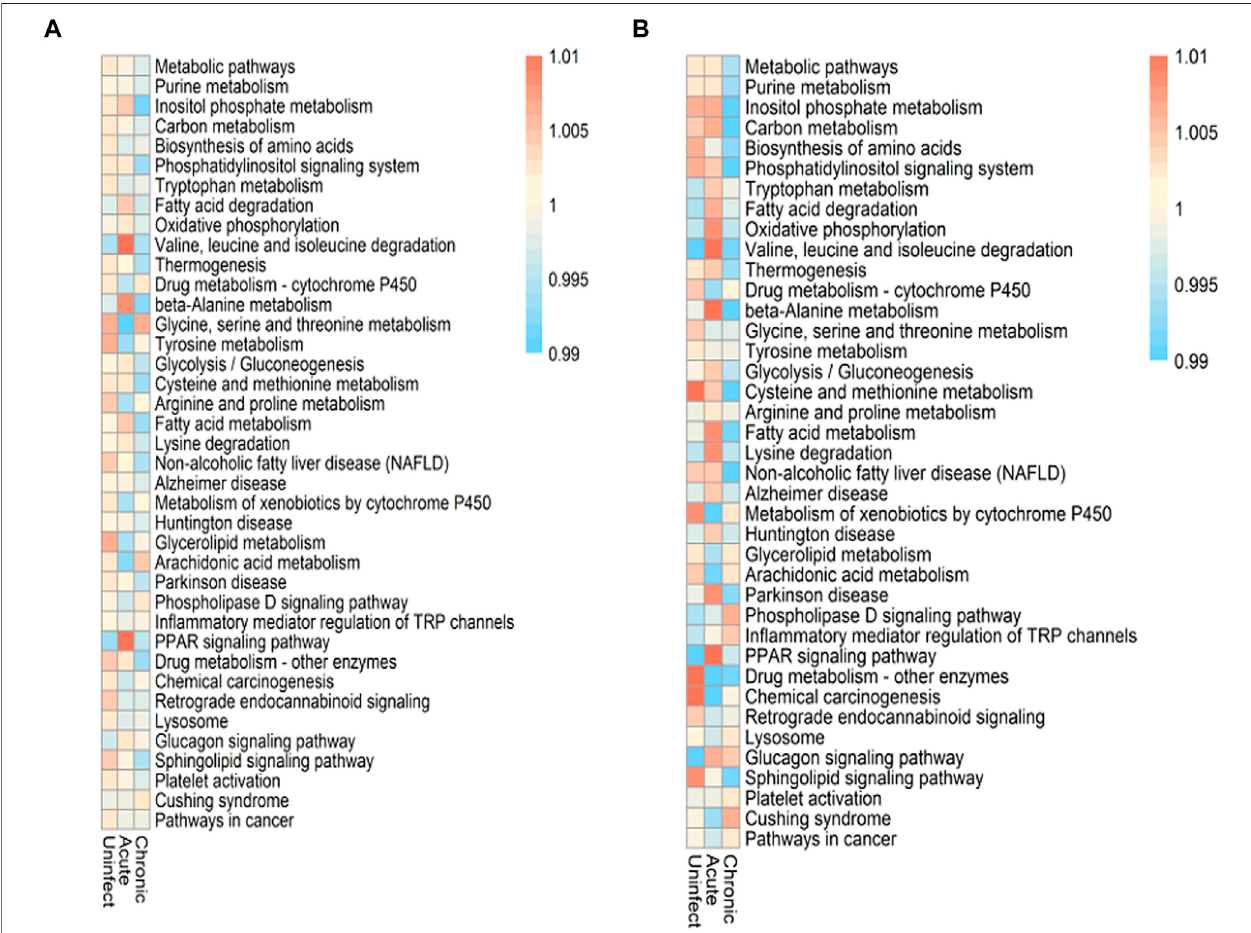
FIGURE 4 | Altered metabolic pathways during HIV infection. (A) Changes and scores of the metabolic pathways in CD4 + T cells before and after infection and during different infection periods. (B) Changes and scores of the metabolic pathways of CD8 + T cells before and after infection and during different infection periods.